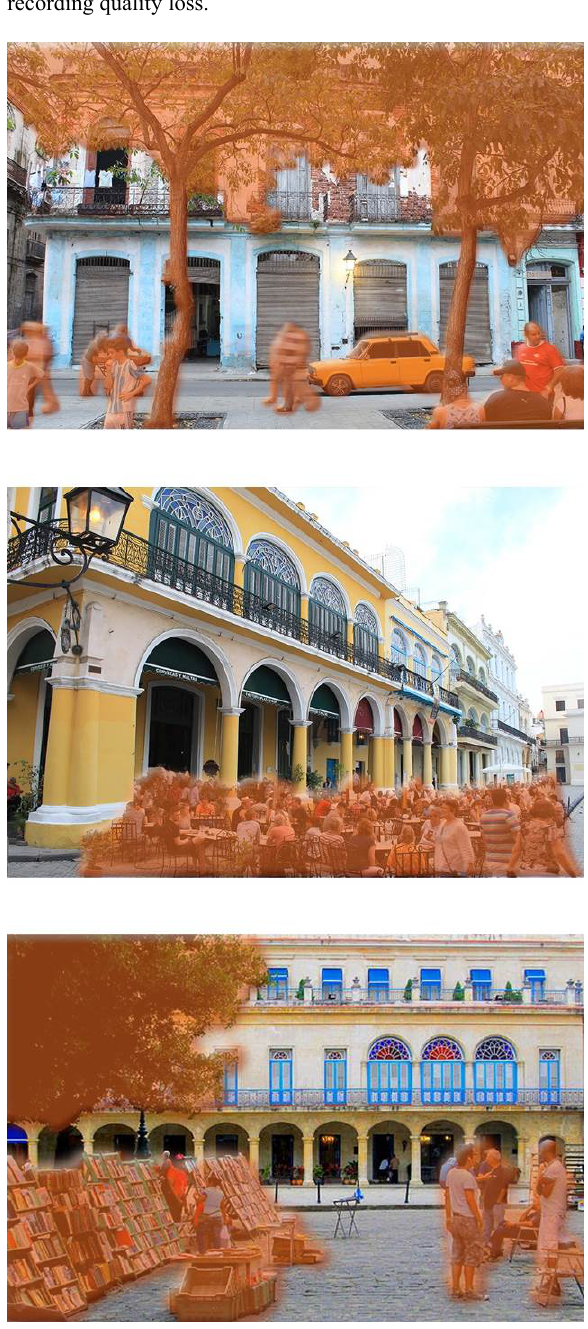
Figure 3. Photographic